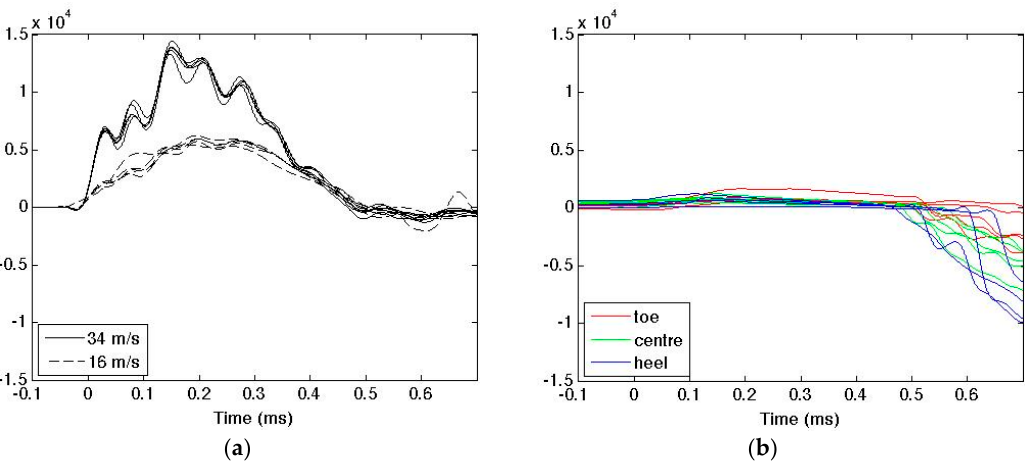
Figure 2. ( a ) Accelerometer signal recorded for five central impacts at both nominal inbound speeds; and ( b ) longitudinal strain signals (measured at the grip) for five trials at each of the three impact locations at nominal inbound speed: 34 m · s − 1 .